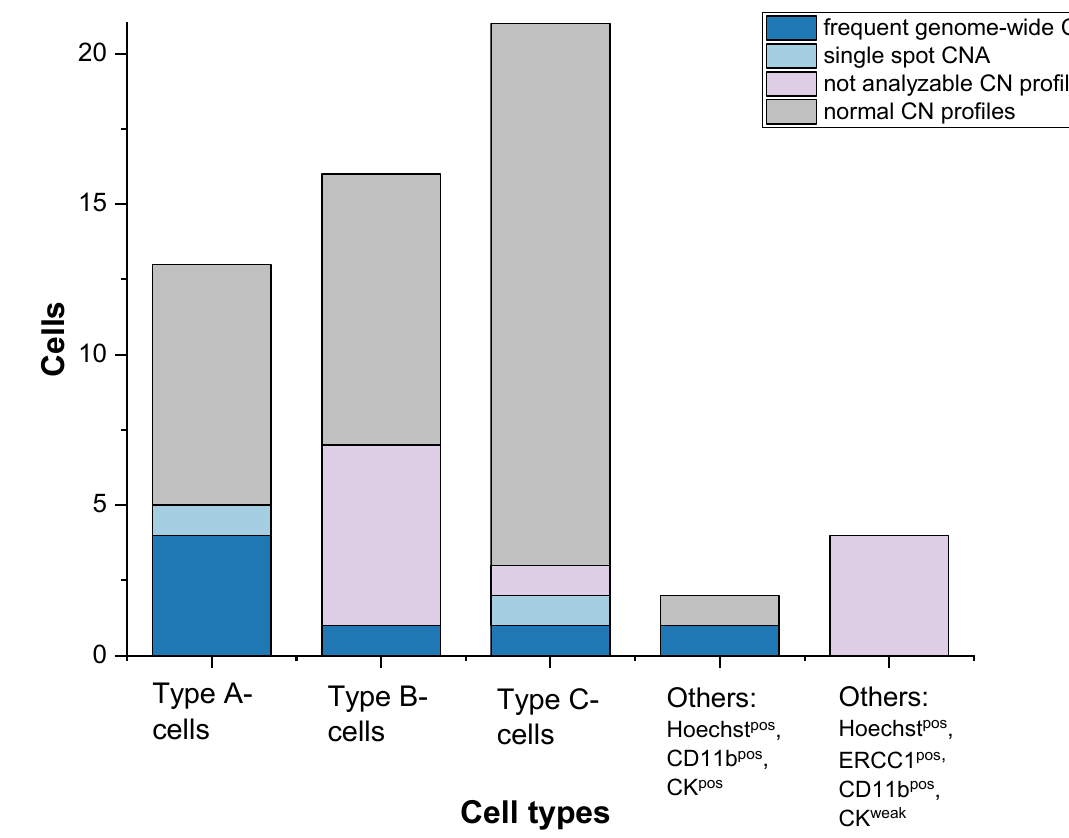
Figure 4 . Copy number alteration frequency in different single cell types. Figure 4. Copy number alteration frequency in different single cell